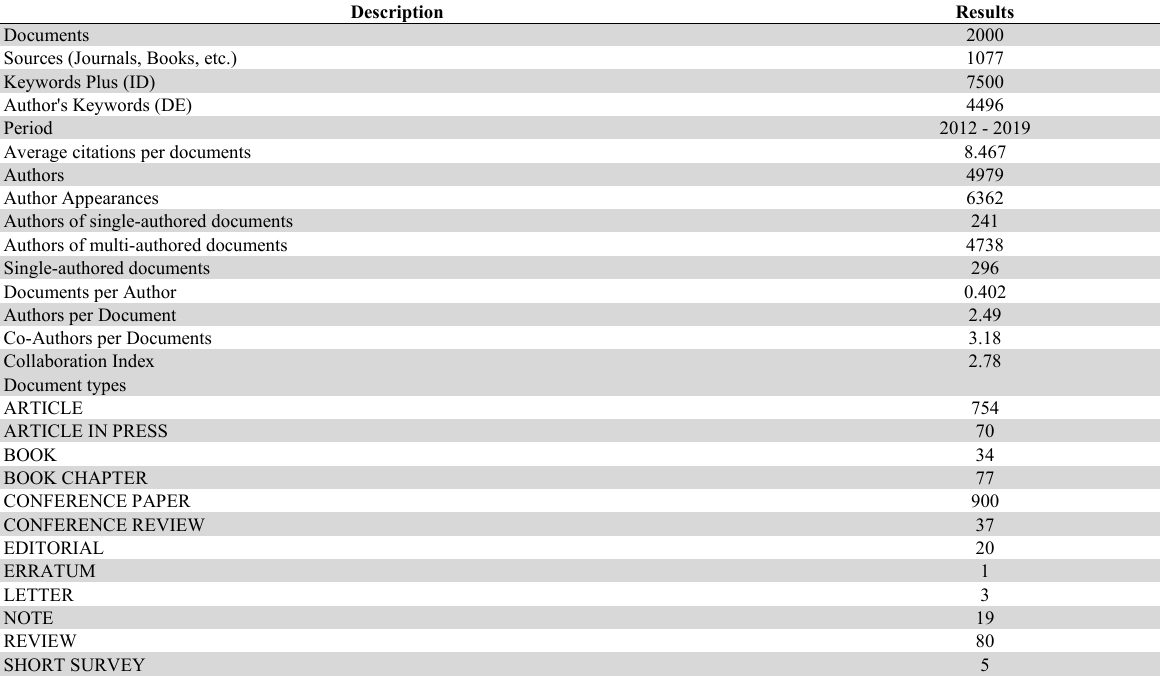
The main information and summary